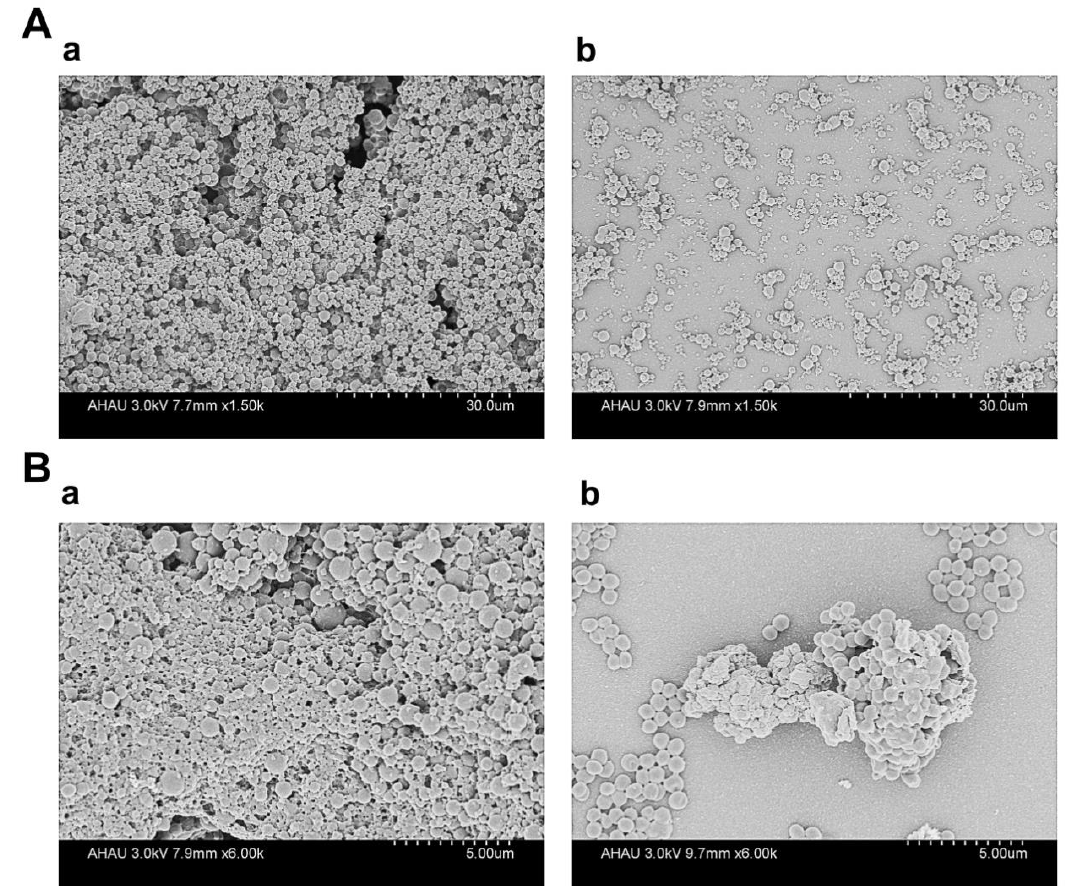
Figure 2. Effects of TS on GBS2 biofilm. ( A ) The crystal-violet stained biofilms of GBS2 in the 96-well plates. ( B ) Results of the biofilm biomass measured by using a microplate reader at a wavelength of 560 nm. Every data point was obtained by averaging the absorbance data from at least four replicate wells (* represents p < 0.05 and ** represents p < 0.01).